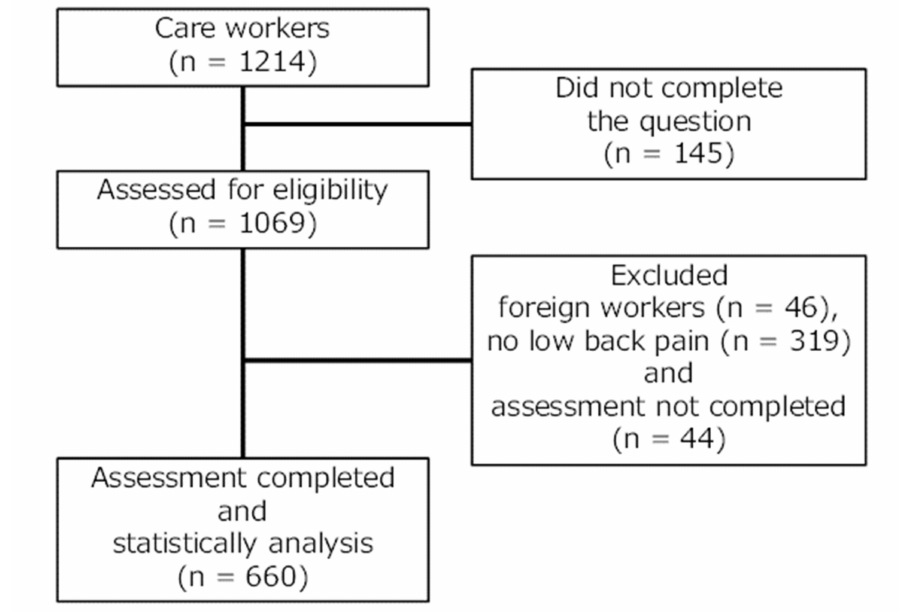
Figure 1. Progression of participants through the assessment including losses to